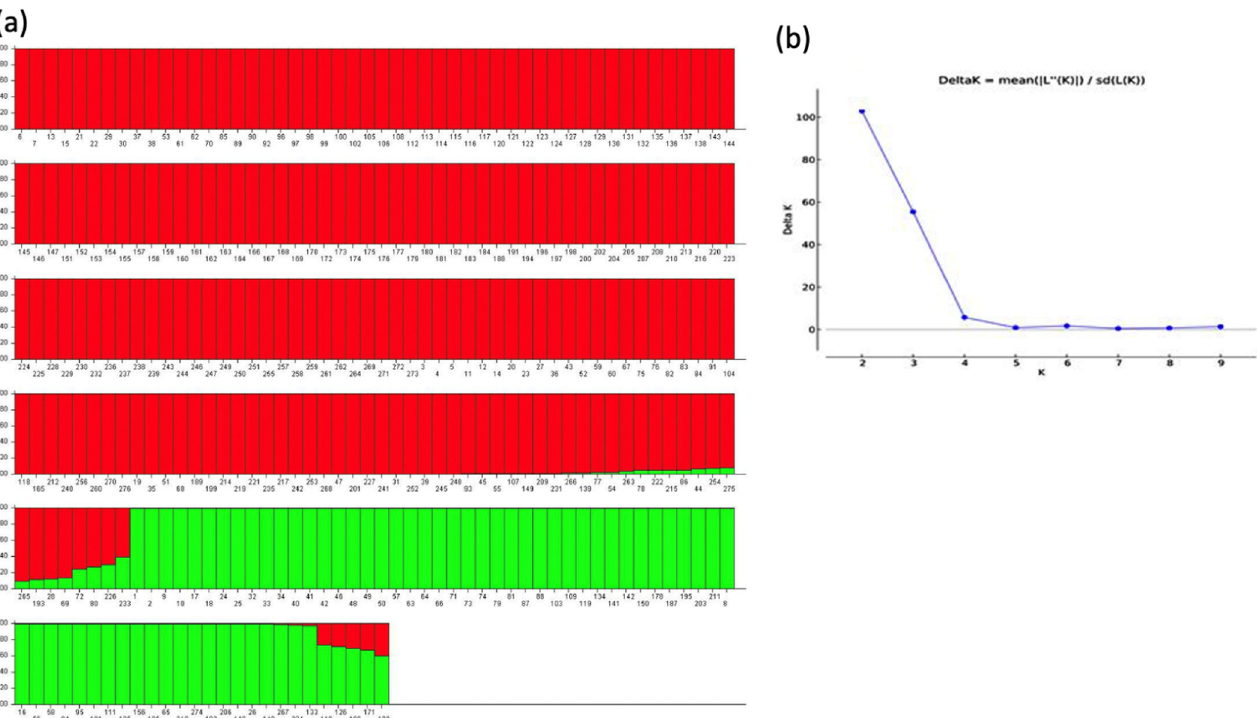
Figure 1. Population structure ( a ) and Evanno test ( b ) for K = 2 clusters and model-based ancestry of accessions with 200,000 burn-ins and 1,000,000 MCMC. Columns represent individual genotypes (numbered on x -axis) and genome admixture ( y -axis) in populations structure. Abbreviations in Evanno test are for subpopulation number (K on the x -axis), and difference in probability for subpopulation (DeltaK on the y -axis). Red and green colors represent genomic representation for the different sub-populations according to best fit of the Evanno test. Both colors found in bars representing genotypes with admixture and the proportion of each subpopulations’ genetic contribution is shown by a crossing line dividing the two colors within the column.